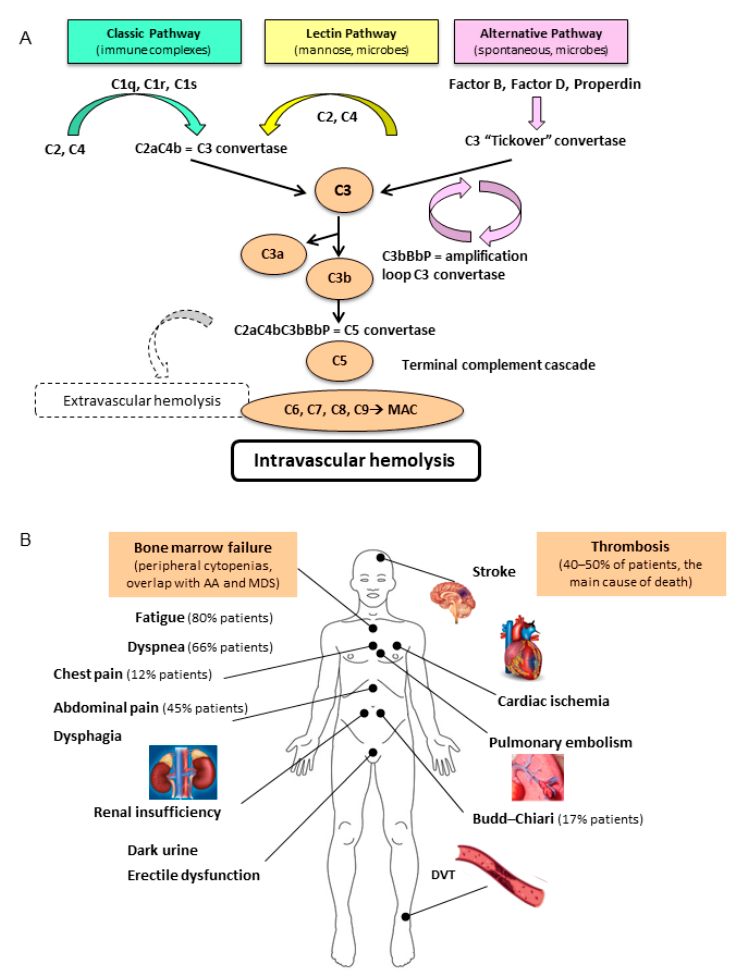
Figure 1. ( A ) The classic, lectin, and alternate pathway of complement activation; ( B ) The heteroge- neous clinical features of paroxysmal nocturnal hemoglobinuria